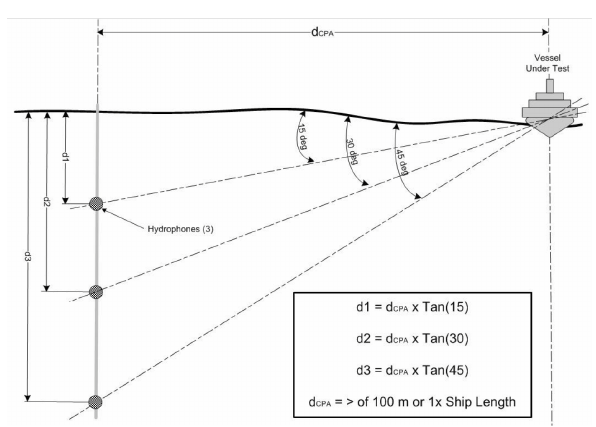
Figure 4: Sketch for underwater noise measurements (from